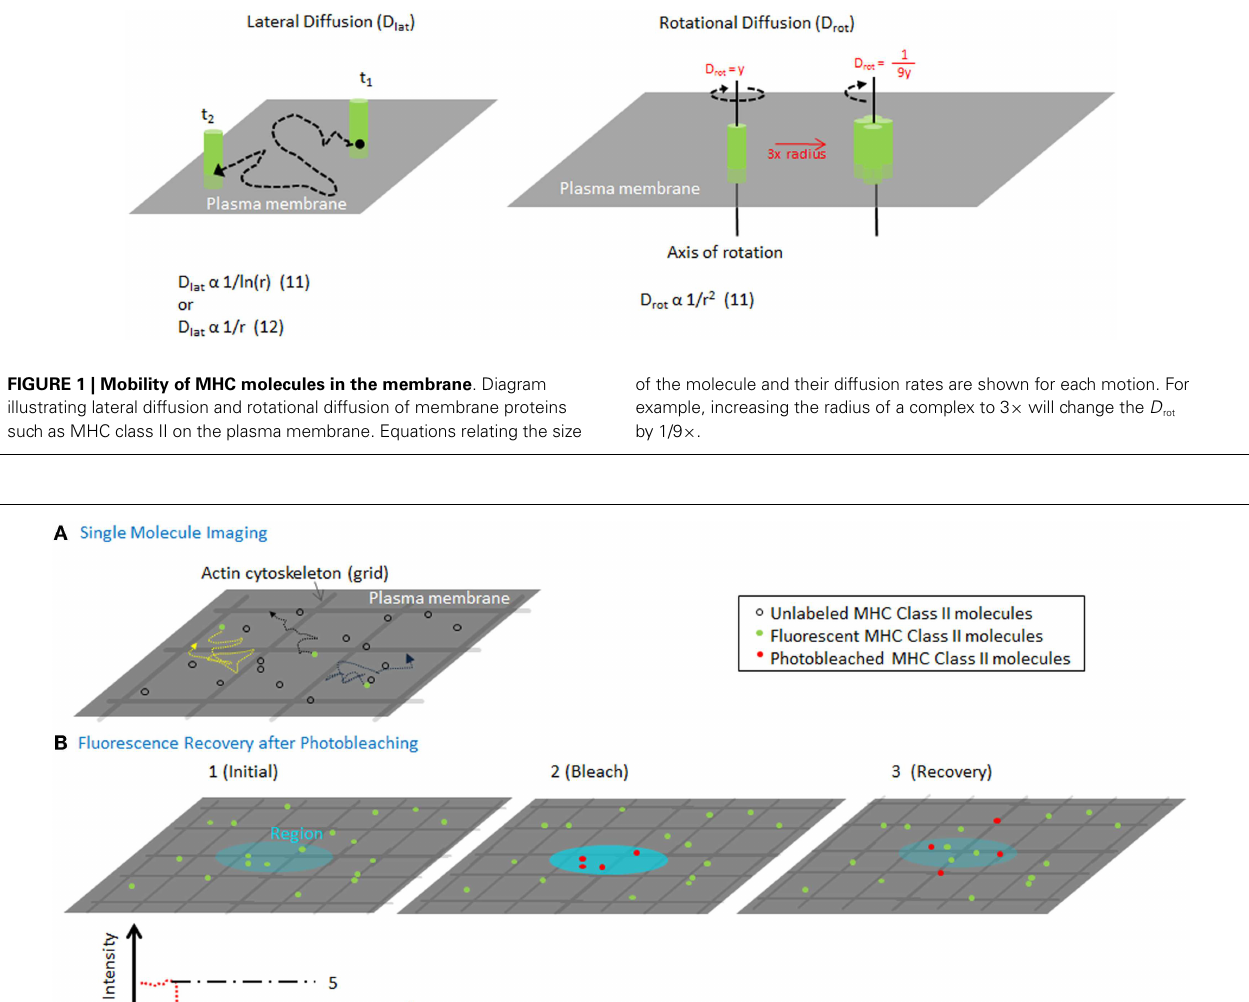
instruments. (2) A pulse of non-attenuated high laser power is delivered to the spot, quickly photobleaching a population of molecules in the region. (3)The low-power monitoring is restored and the recovery of mobile fluorescent molecules to the region.The fluorescence intensity (in red) is plotted vs. time, to show the three time segments. Based on the final recovery (4) vs. the initial intensity (5), we can compute the mobile fraction.The fit of the recovery can be used to calculate a diffusion coefficient for lateral mobility. As the spot sizes are always larger than size actin meshwork, the rate of diffusion and recovery is sensitive to interactions with the